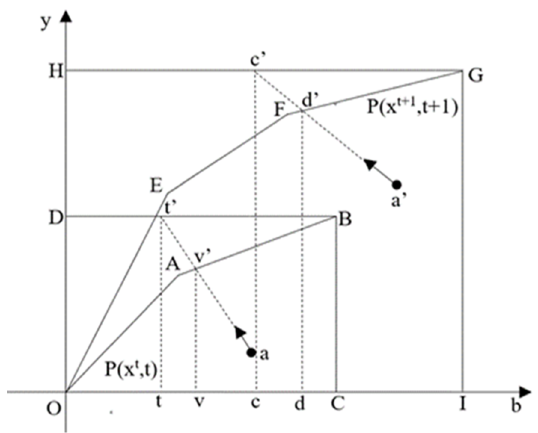
Figure 2. Change of opportunity cost.